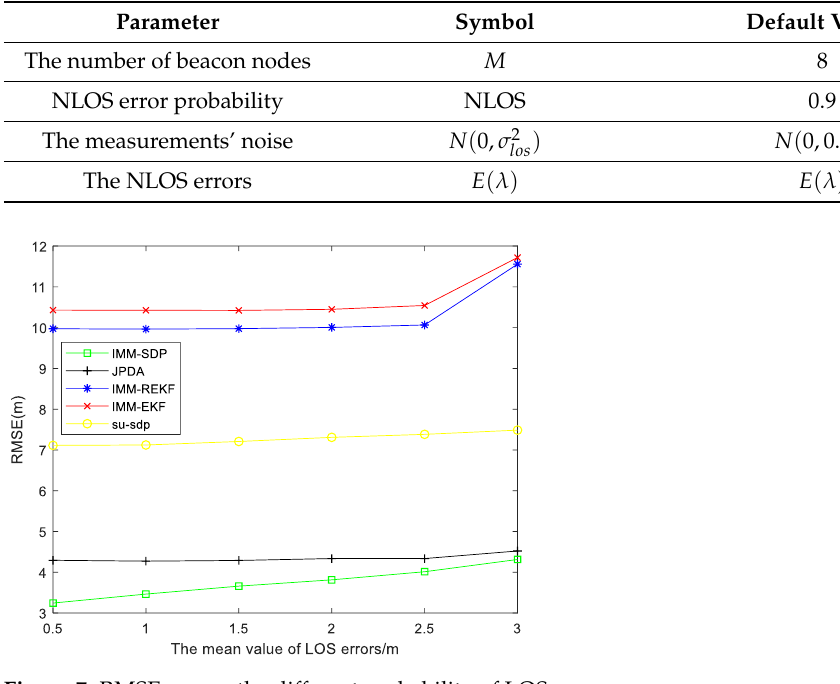
Table 3. Uniform distribution parameter map .